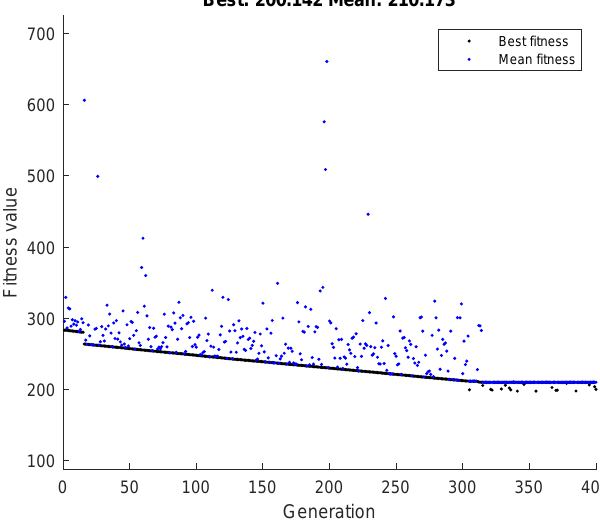
Figure 6. Optimization process using genetic